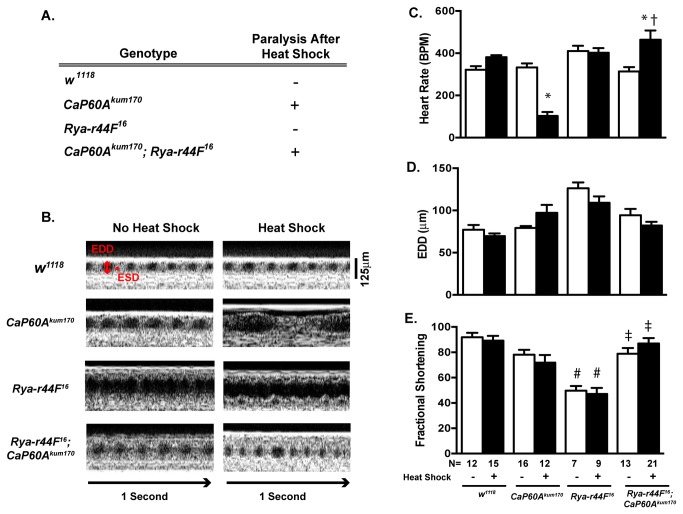
The effects of Calcium Release mutations on the CaP60A
kum170 cardiac phenotypes.
A. Heat shock induced paralysis in heterozygous CaP60A
kum170 flies as well as in transheterozygous mutants carrying both CaP60A
kum170 and a mutation in Ryanodine receptor (Rya-r44F16). No heat shock induced paralysis was noted in the single Rya-r44F
16 mutants or w
1118. B. Representative OCT images from w
1118, CaP60A
kum170, Rya-r44F
16, CaP60A
kum170; Rya-r44F
16 with and without 10-minute heat shock; A 125 micron standard and one-second bar are shown. EDD= End diastolic dimension, ESD=End systolic dimension. C. Heart rate, D. EDD and E. Fractional Shortening (%) in w
1118, CaP60A
kum170, Rya-r44F
16, CaP60A
kum170
; Rya-r44F
16 at baseline and after 10-minute heat shock. *p<0.0002 vs. non-heat shock state of the same genotype, † p<0.0001 vs. CaP60A
kum170 after heat shock, #p<0.0001 vs. w
1118 of the same treatment condition, ‡p<0.0002 vs. Rya-r44F
16 of the same treatment condition by one-way ANOVA with Tukey’s multiple comparisons test.